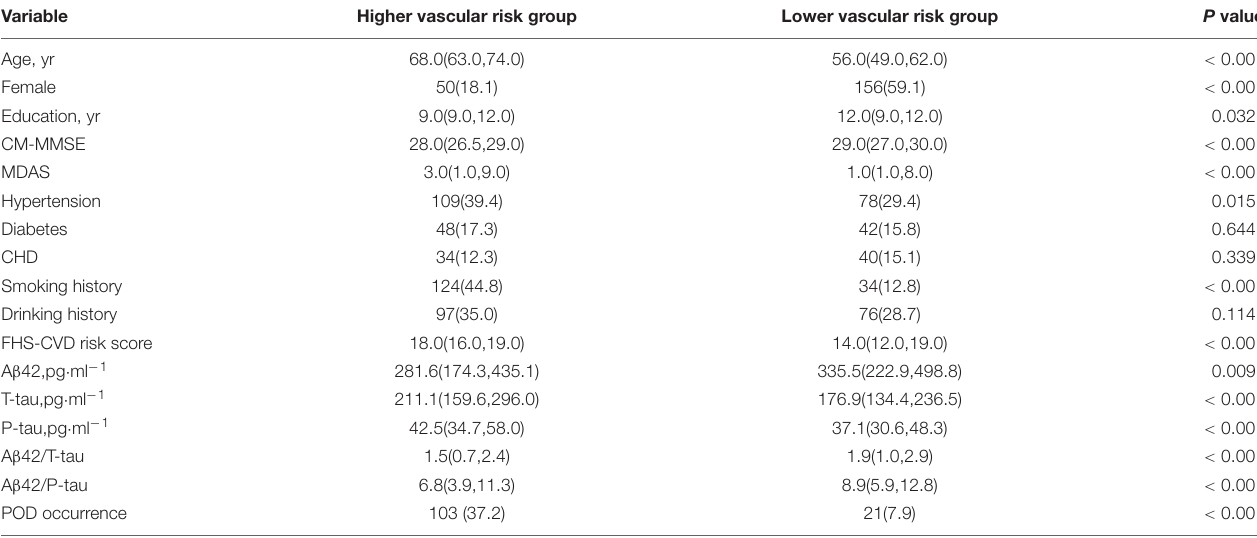
TABLE 1 | Demographic and clinical characteristics of participants.